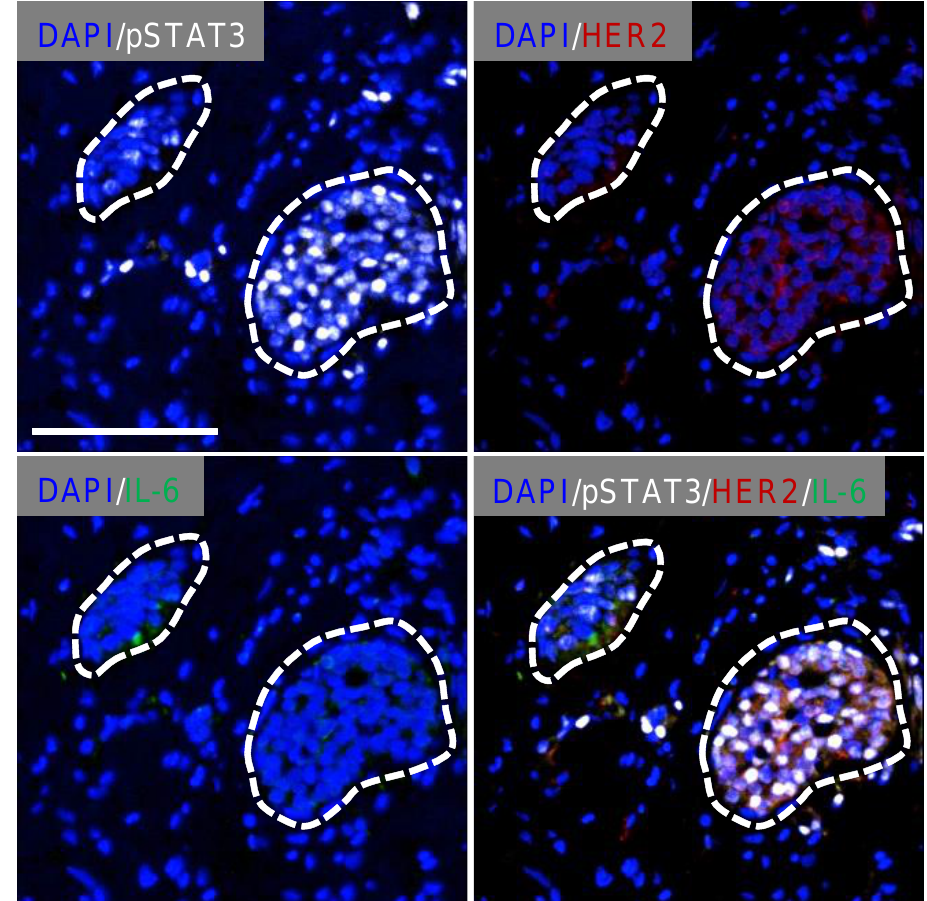
Figure 1. Localization of HER2, pSTAT3 and IL-6 in human inflammatory breast cancers. FFPE sections from human inflammatory breast cancer pre-treatment core biopsies were co-stained with HER2 (red), IL-6 (green) and pSTAT3 (white) antibodies using multiplexed multispectral imaging and counterstained with DAPI (blue) to visualize the nuclei (see Section 2). The specimen shown is a luminal A (ER pos , PgR pos , HER2 neg ) tumor (INFLAM #2, Table S1) which displays co-localization of cell surface HER2 expression and nuclear pSTAT3 in a cluster of tumor cells with diffuse IL-6 positivity in an adjacent tumor cell cluster. Scale bar represents 100 μ m.